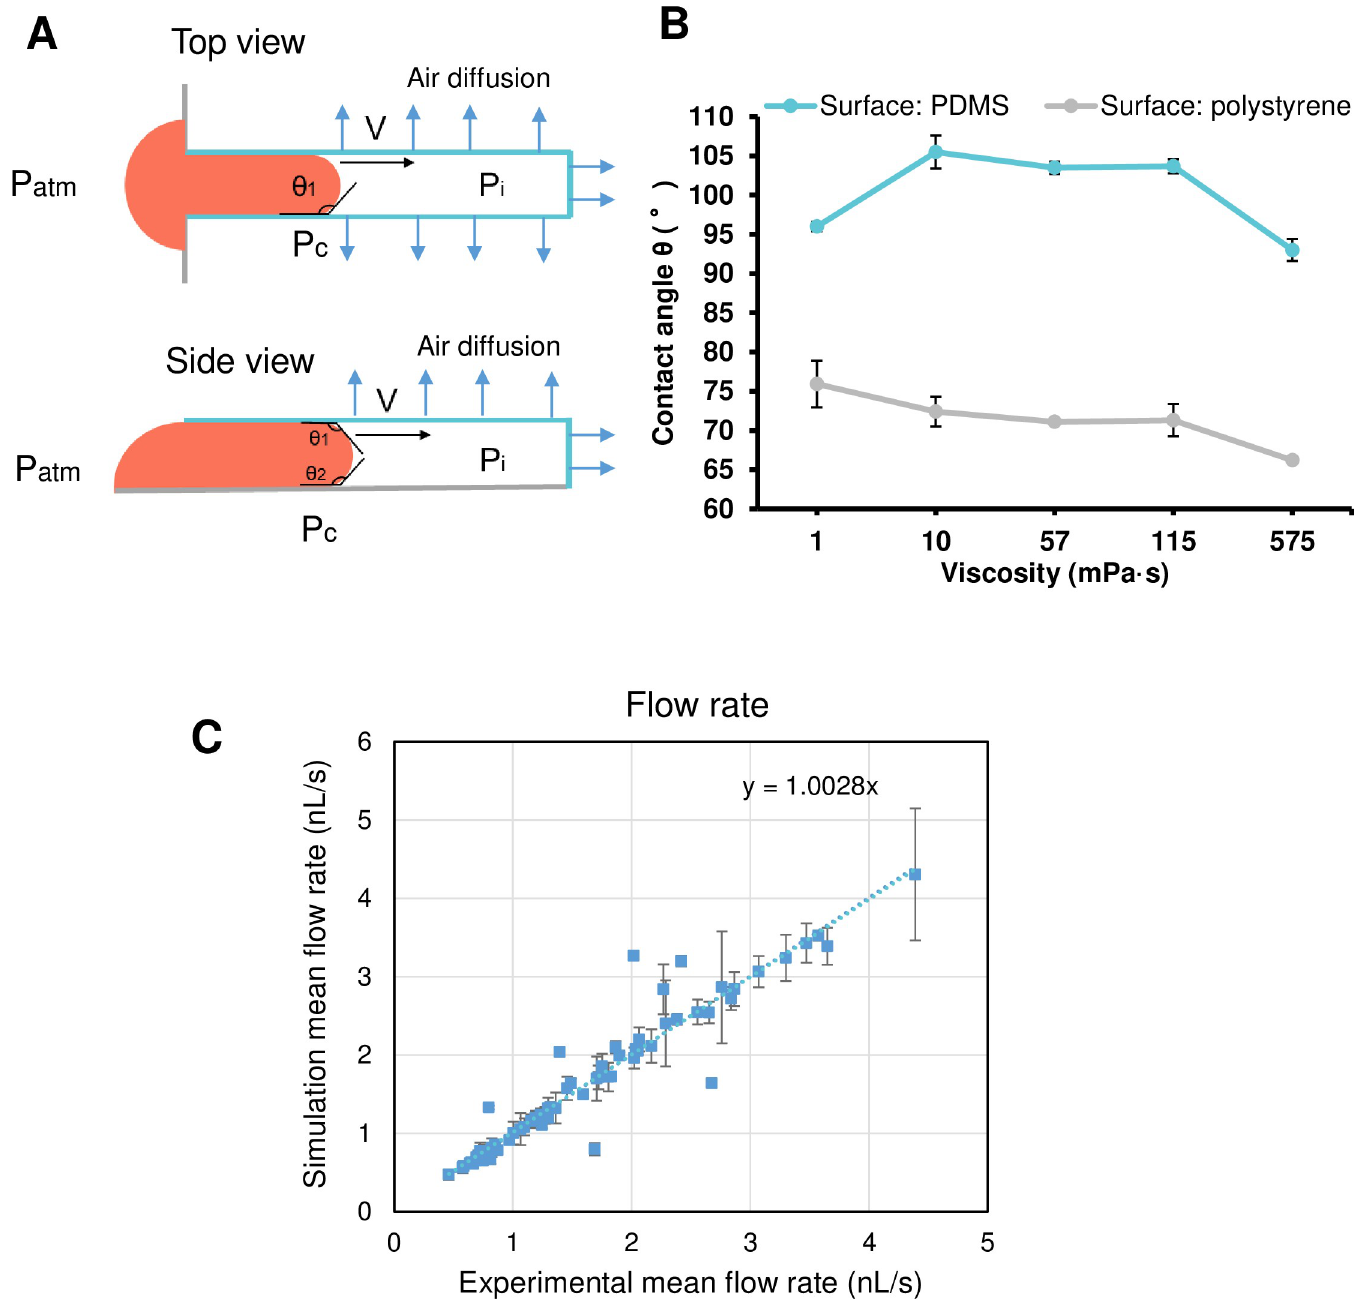
Fig 3. Simulation model for casting in the degassed PDMS dead-end channel. (A) Pressures in the degassed channel. P atm is the atmosphere pressure; P i is the air pressure inside the channel; P c is the pressure caused by capillary force; θ 1 and θ 2 are the dynamic contact angles of the fluid with, respectively, the wall and the bottom material of the channel. (B) Graph showing contact angle of agarose solution of different viscosity. Data points and error bars indicate mean ± SD (N = 5). (C) Image showing the correlation between simulation and experimental